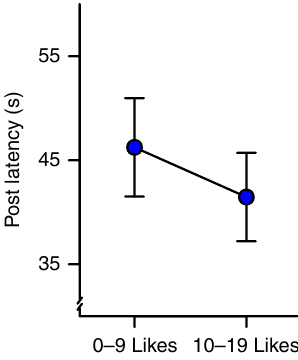
Fig. 4 Computational phenotypes in reward learning on social media. a Cluster analysis ( n = 4168 independent individuals from Study 1 & 2) of the estimated (cid:1) RL model parameters indicated that there were four distinct individual difference pro fi les in reward learning on social media. For illustration, the cluster assignments are plotted on the two fi rst principal components (PC). Source data are provided as a Source Data fi le. b Pro fi le of median (cid:1) RL model parameter values (standardized) for each cluster; ɑ = learning rate, P = initial response policy, C = effort cost sensitivity. Source data are provided as a Source Data fi